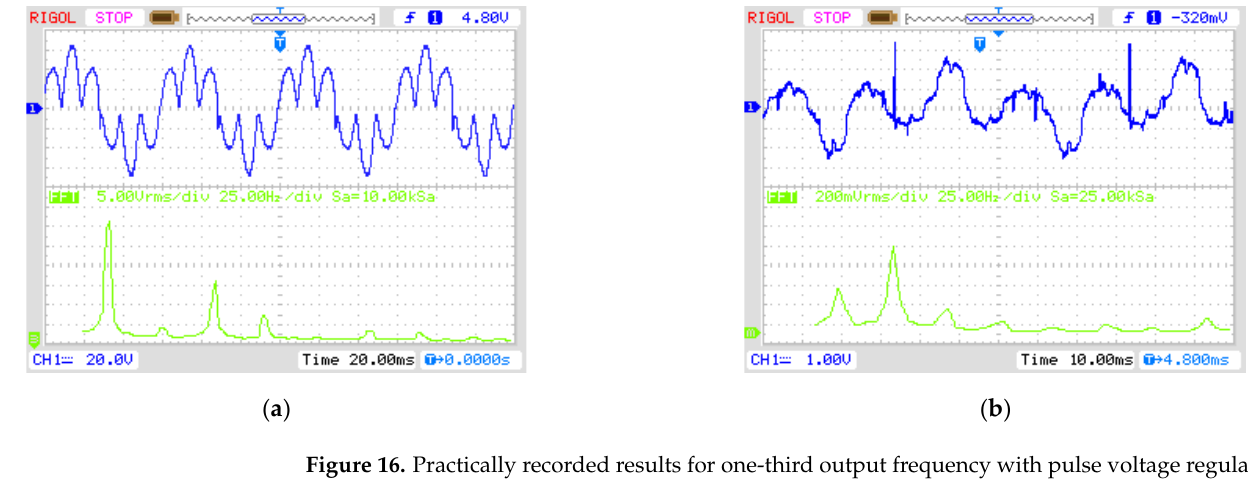
( c ) Figure 17. Practically recorded results without pulse voltage regulation capabilities: ( a ) output volt- age and its FFT spectrum for one half output frequency; ( b ) output voltage and its FFT spectrum for one-third output frequency; ( c ) input current and its FFT spectrum.